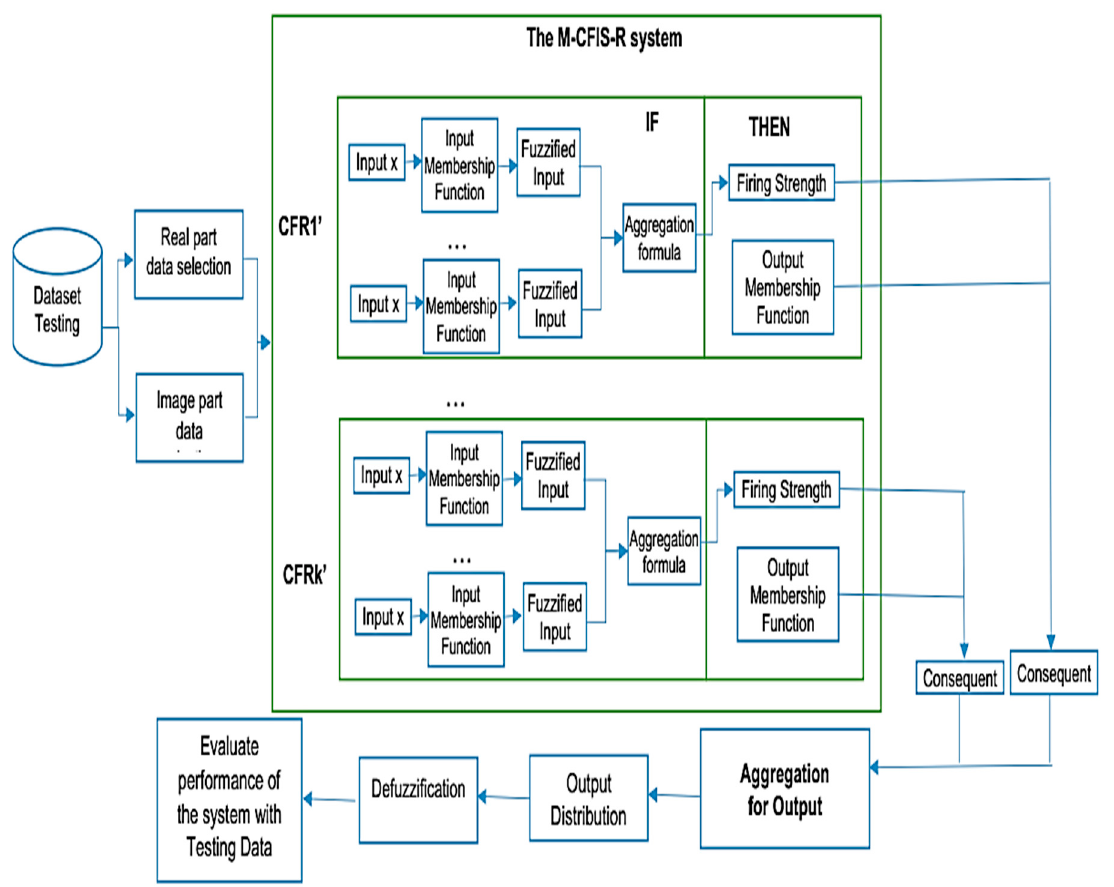
Figure 2. Testing diagram for the proposed model.